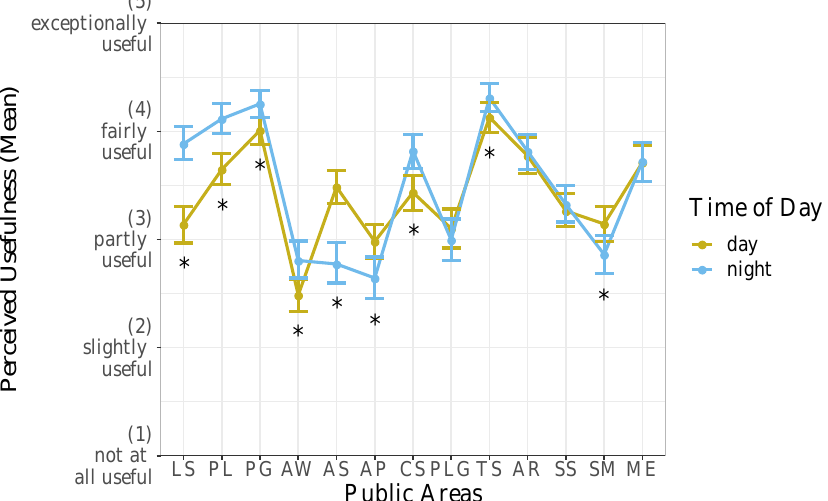
Figure 3. Interaction public area × time of day. Note: Significant results are marked with asterisks (*), ρ ≤ 0.05. Standard error of means are